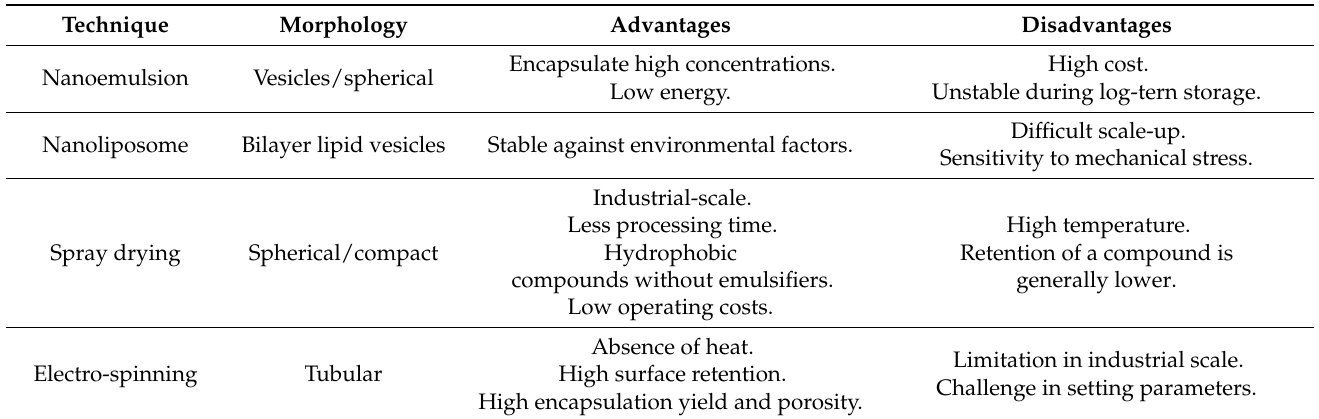
Table 1. Nanoencapsulation methods applied for flavonoids.